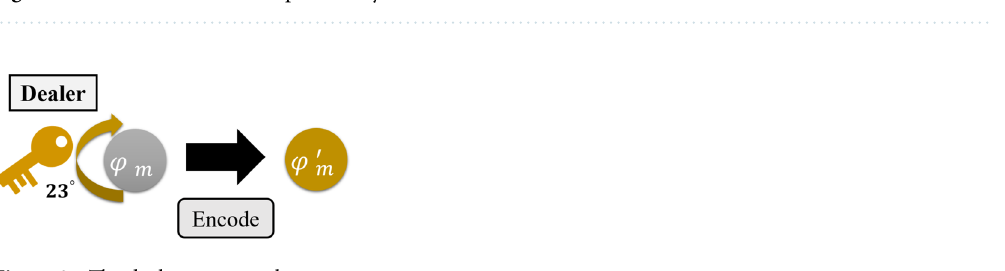
Figure 2. The dealer encrypts the quantum